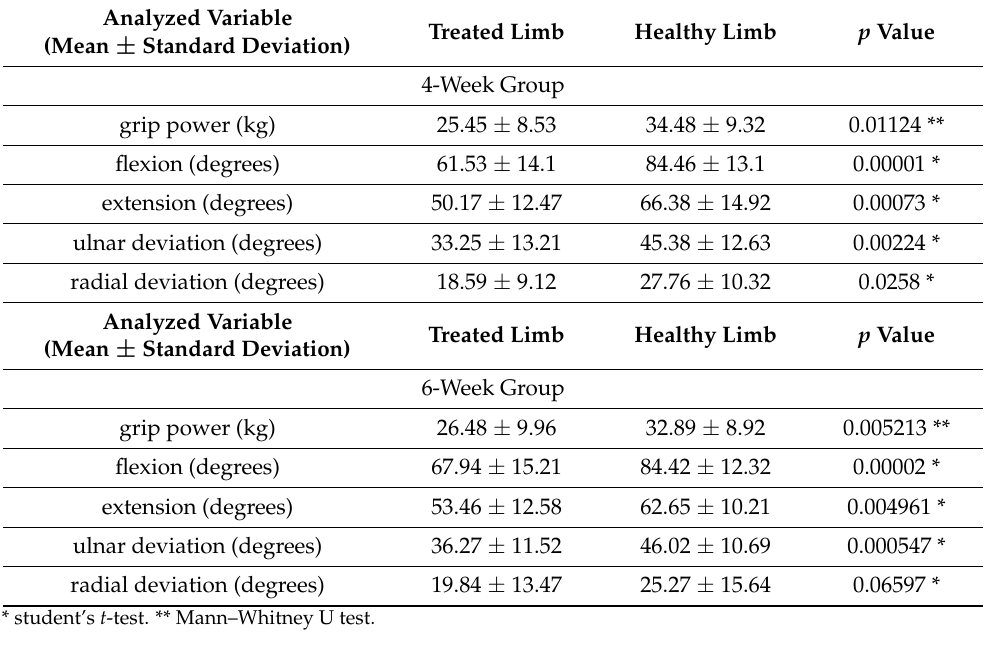
Table 2. The grip power and range of motion symmetry in the 4-week group and 6-week group.